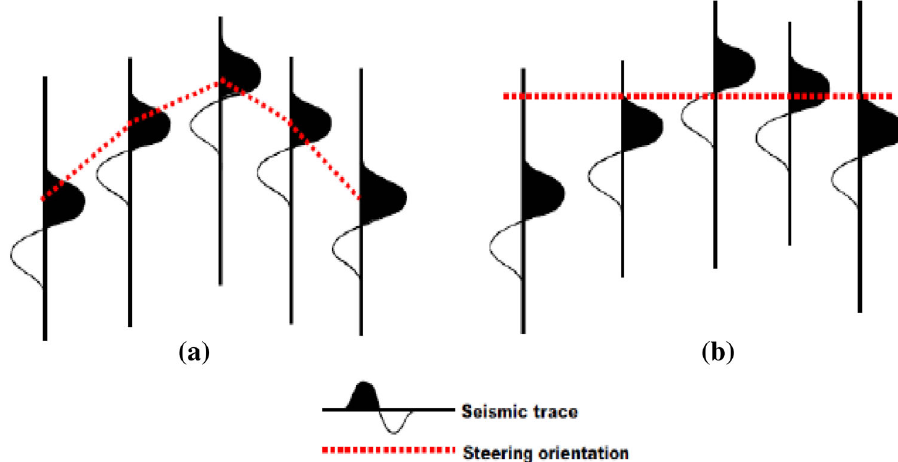
schematic illustration of dip- steering computation applied to the seismic data (Tingdahl